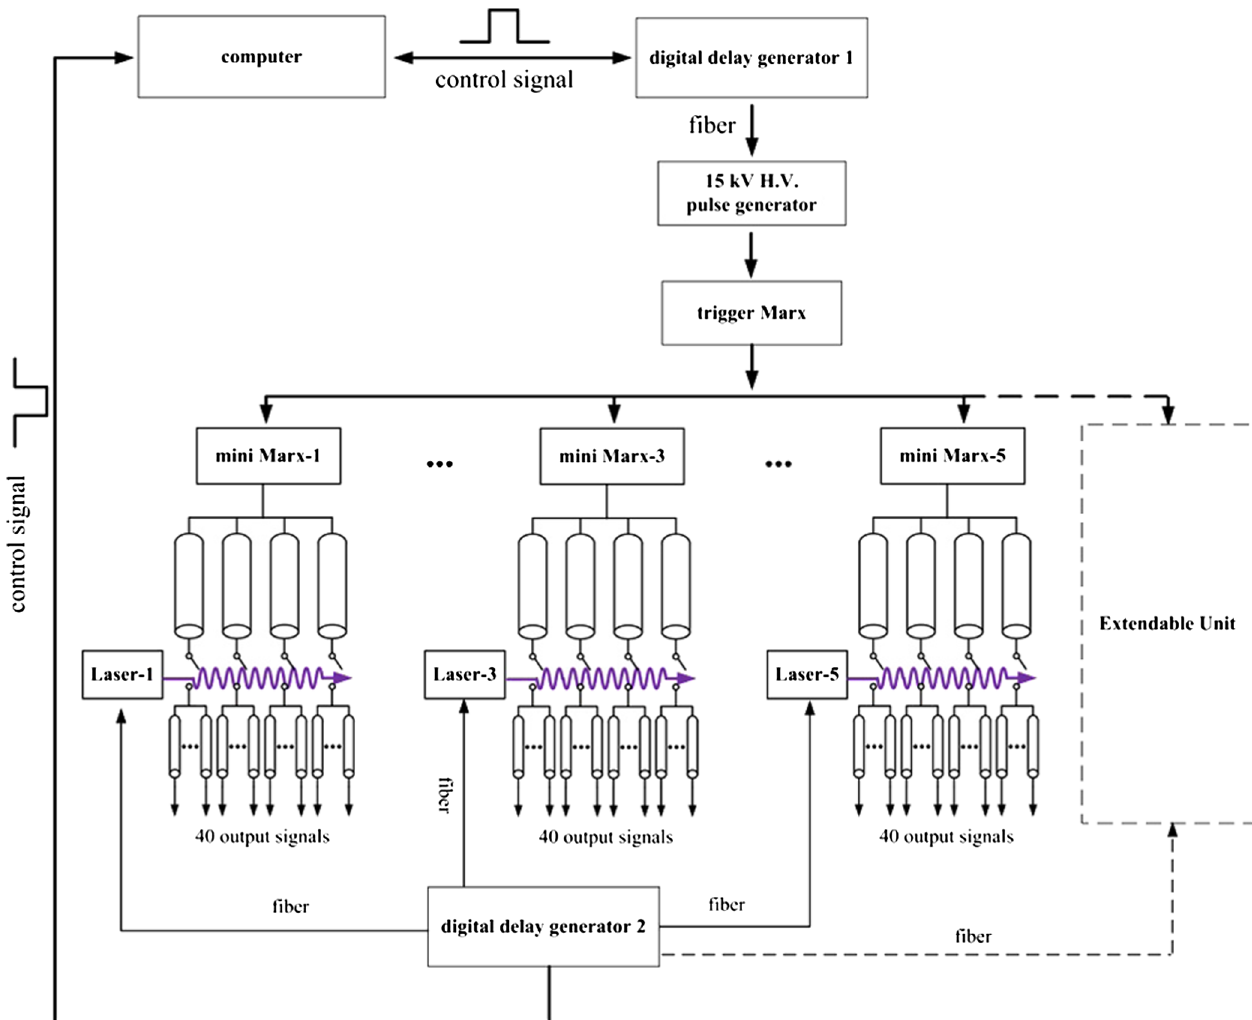
FIG. 12. Schematic of the extendable trigger system. Each unit has four pulse forming lines, four laser triggered gas switches and 40 trigger outputs. The system is extendable when a trigger unit is added to the system. The unit is controlled by a voltage pulse from the upper-level trigger